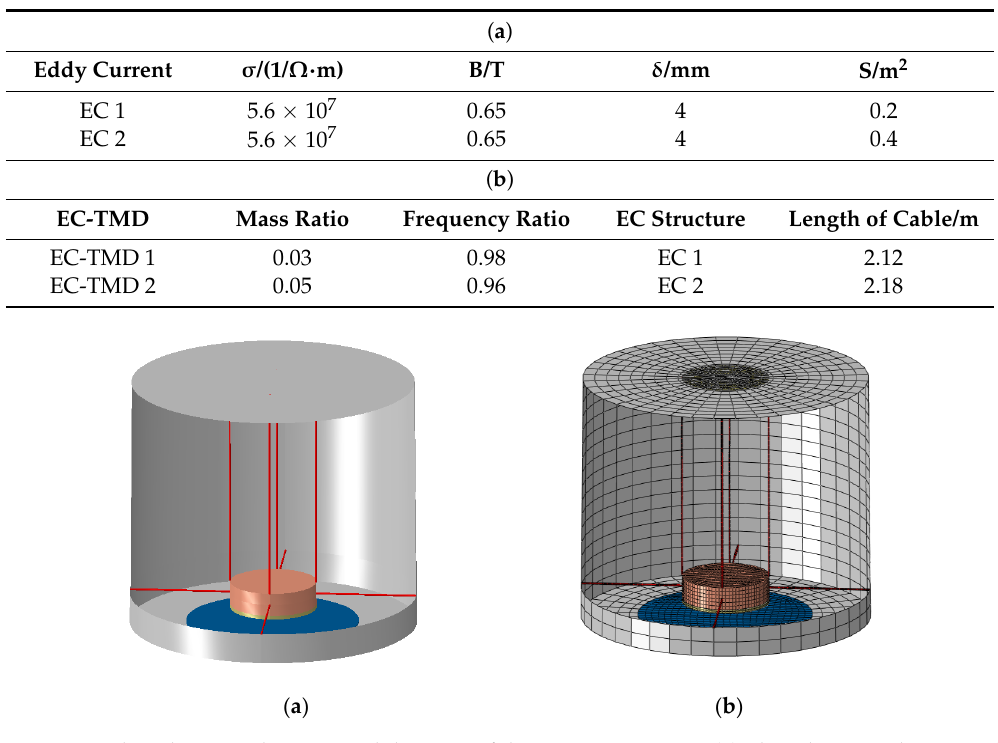
Figure 13. The schematic diagram and the FEM of the EC-TMD system: ( a ) The schematic diagram of the EC-TMD; ( b ) The FEM of the EC-TMD system. the EC-TMD; ( b ) The FEM of the EC-TMD